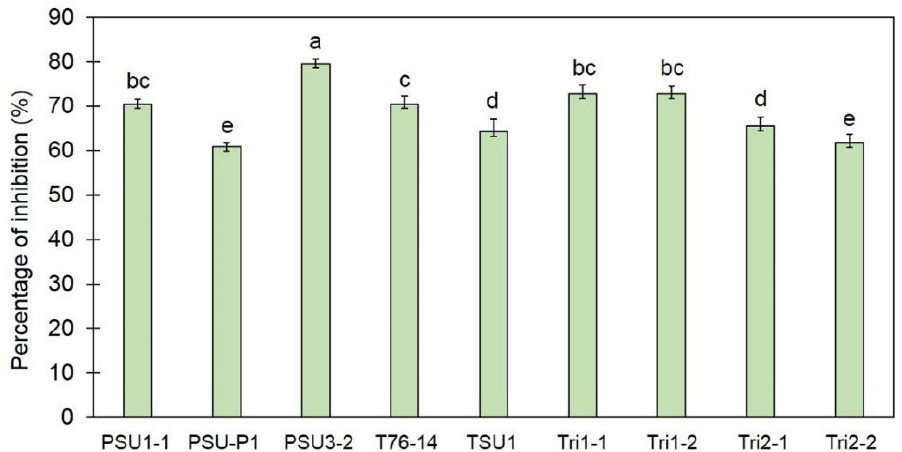
Figure 1. Percentage inhibition of Trichoderma spp. against Colletotrichum gloeosporioides . Different letters indicate statistically significant differences among treatments ( p < 0.05) using Tukey’s test .